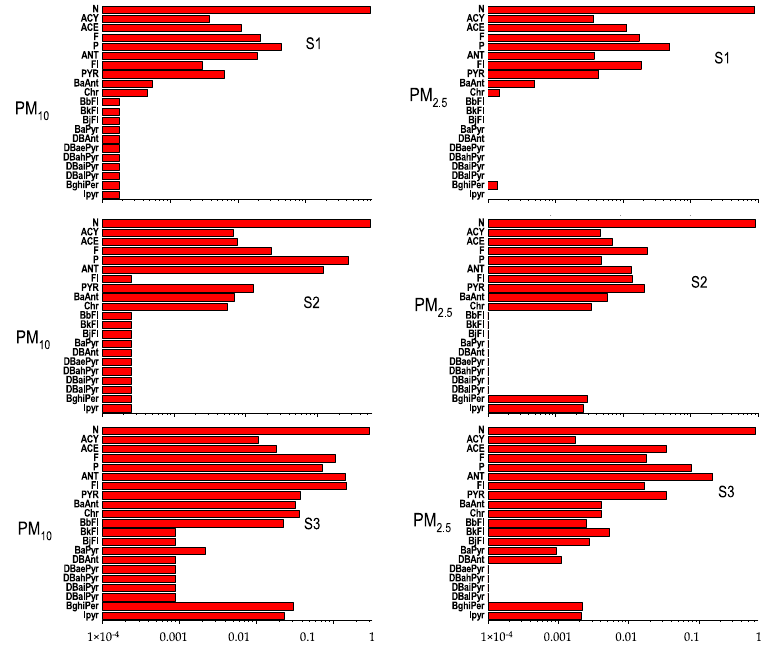
Figure 7. PAHs profiles for U site—naphthalene and phenanthrene, markers of ship emissions, show greater concentration in every sampling period and sector (in figure the spring sampling), indicating a significant contribution of port area to the overall emissions (N: